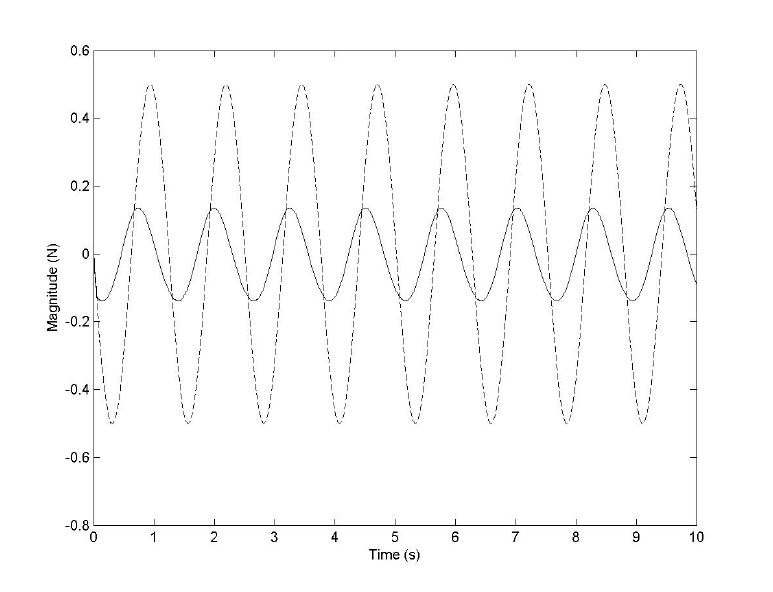
Fig. 26. Transmitted force variations of the system using the NN controller subjected to periodic engine disturbance. Open loop (–) and NN controlled (solid).